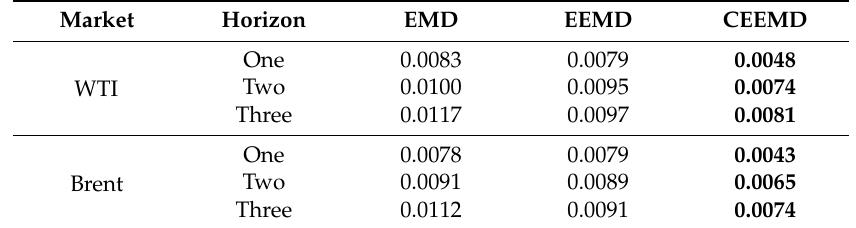
Table 8. The MAPE values of different decomposition methods on WTI and Brent crude oil prices.